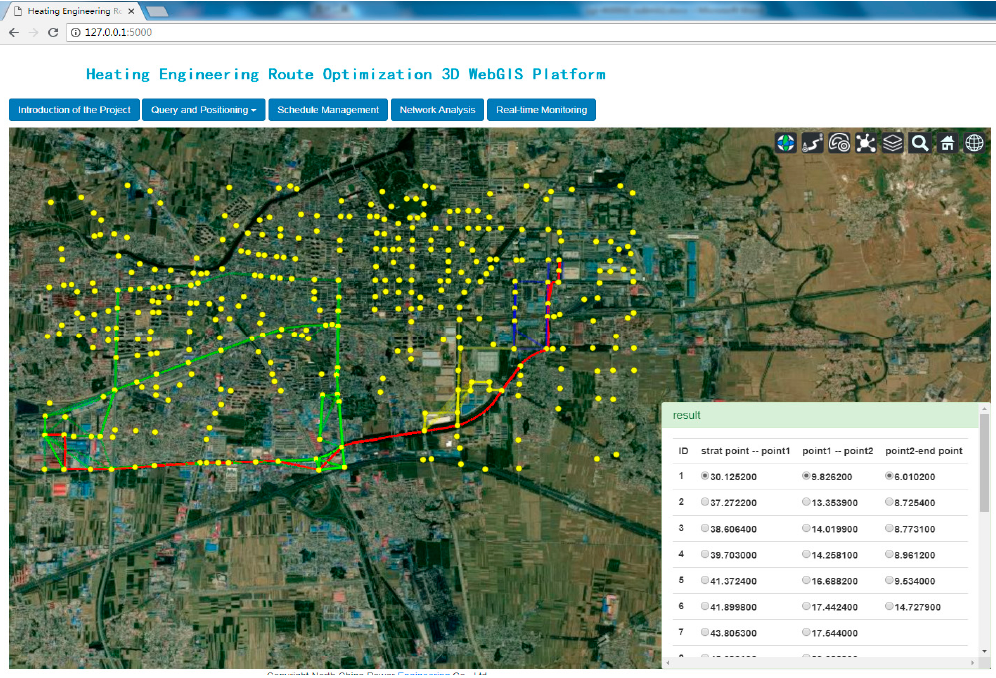
Figure 11. Best route solved by the interactive design platform (red line).